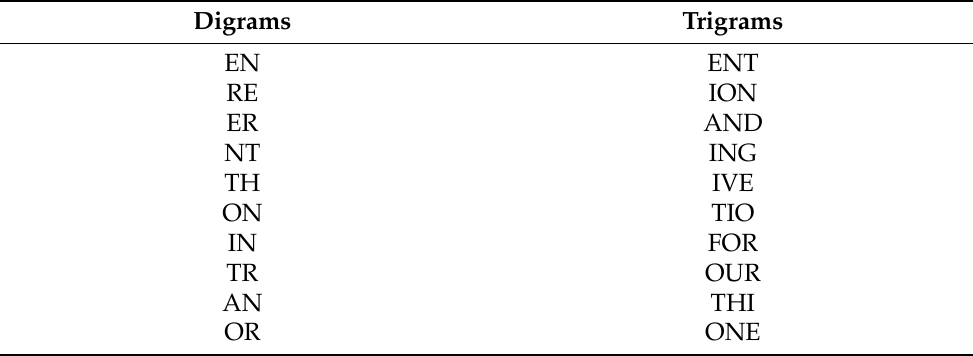
Table 1. Most frequent digrams and trigrams in the English